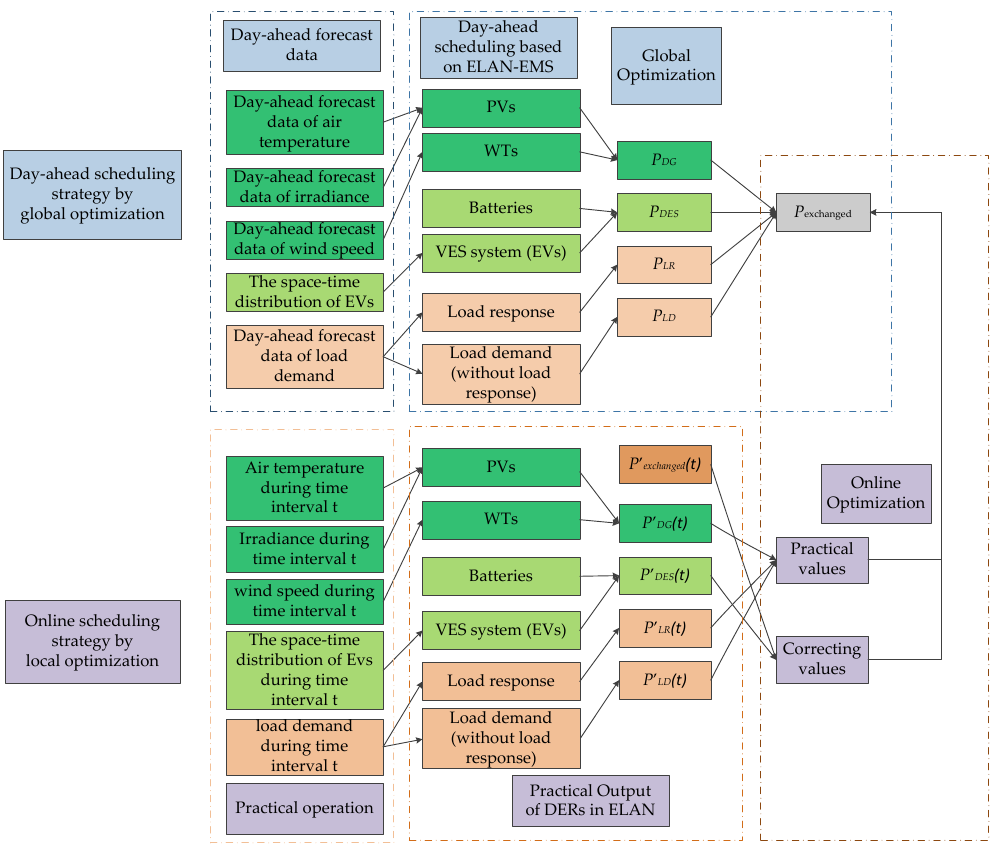
Figure 4. Flowchart of the two-step optimization framework for scheduling problem based on ELAN-EMS.